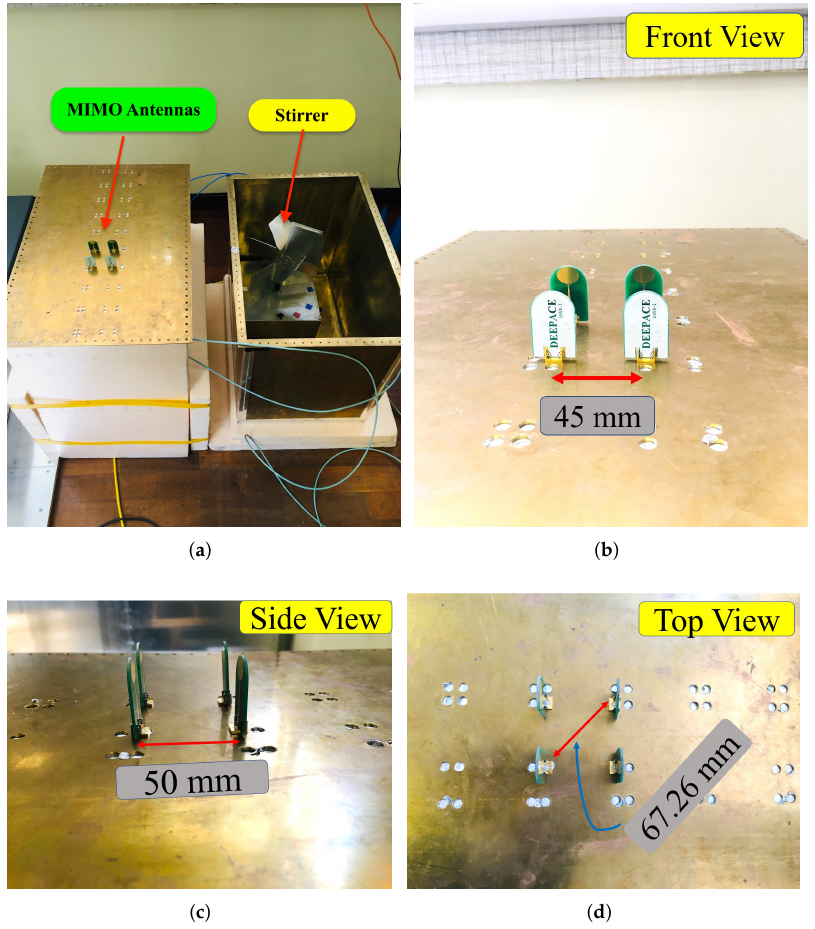
Figure 2. The 2 × 2 MIMO BER and EVM measurement setup inside the cavity ( a ) MIMO antennas and an inside view of the cavity, ( b ) front view of the antennas, ( c ) side view of the antennas, ( d ) top view of the